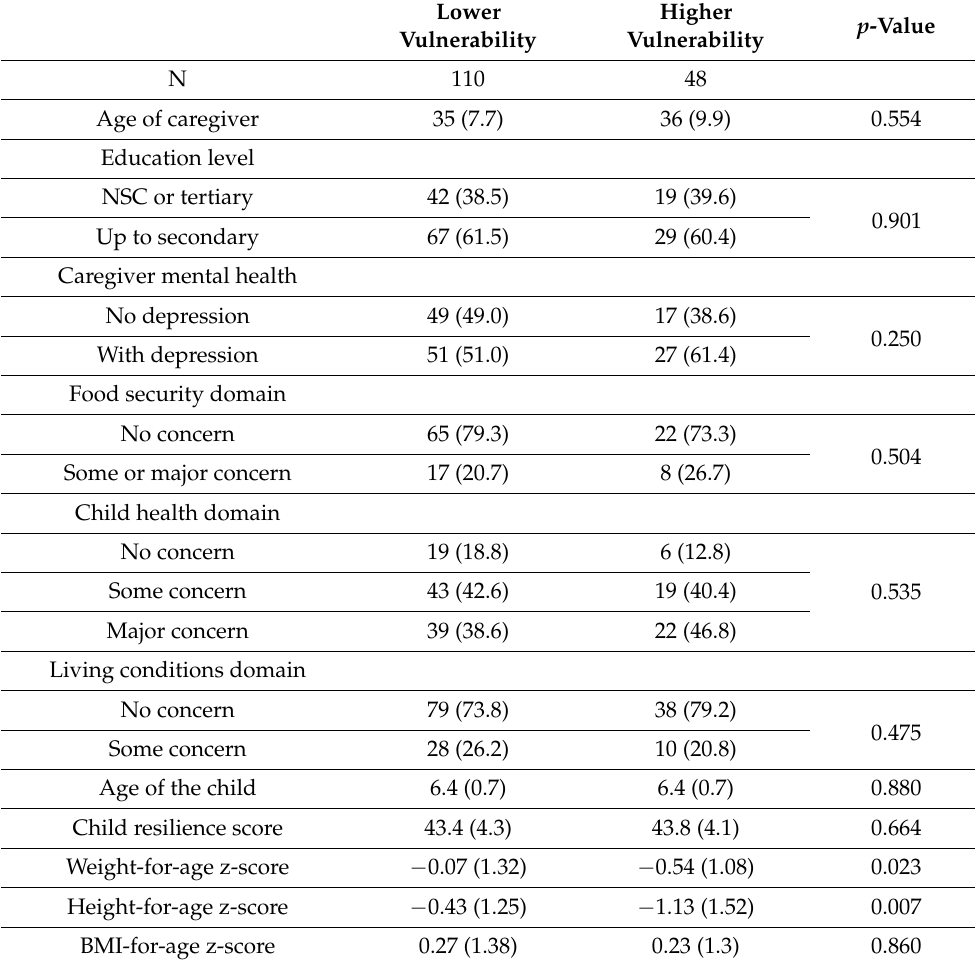
Table 3. The effect of the income vulnerability (index defined by dependence on grants and high household size) on demographic characteristics and child growth